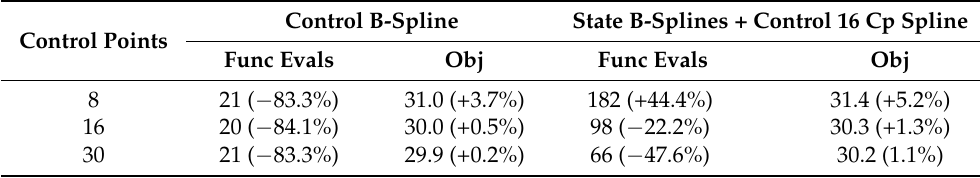
Table 1. Study of b-spline defined control and state variables in trajectory optimization. Control Points